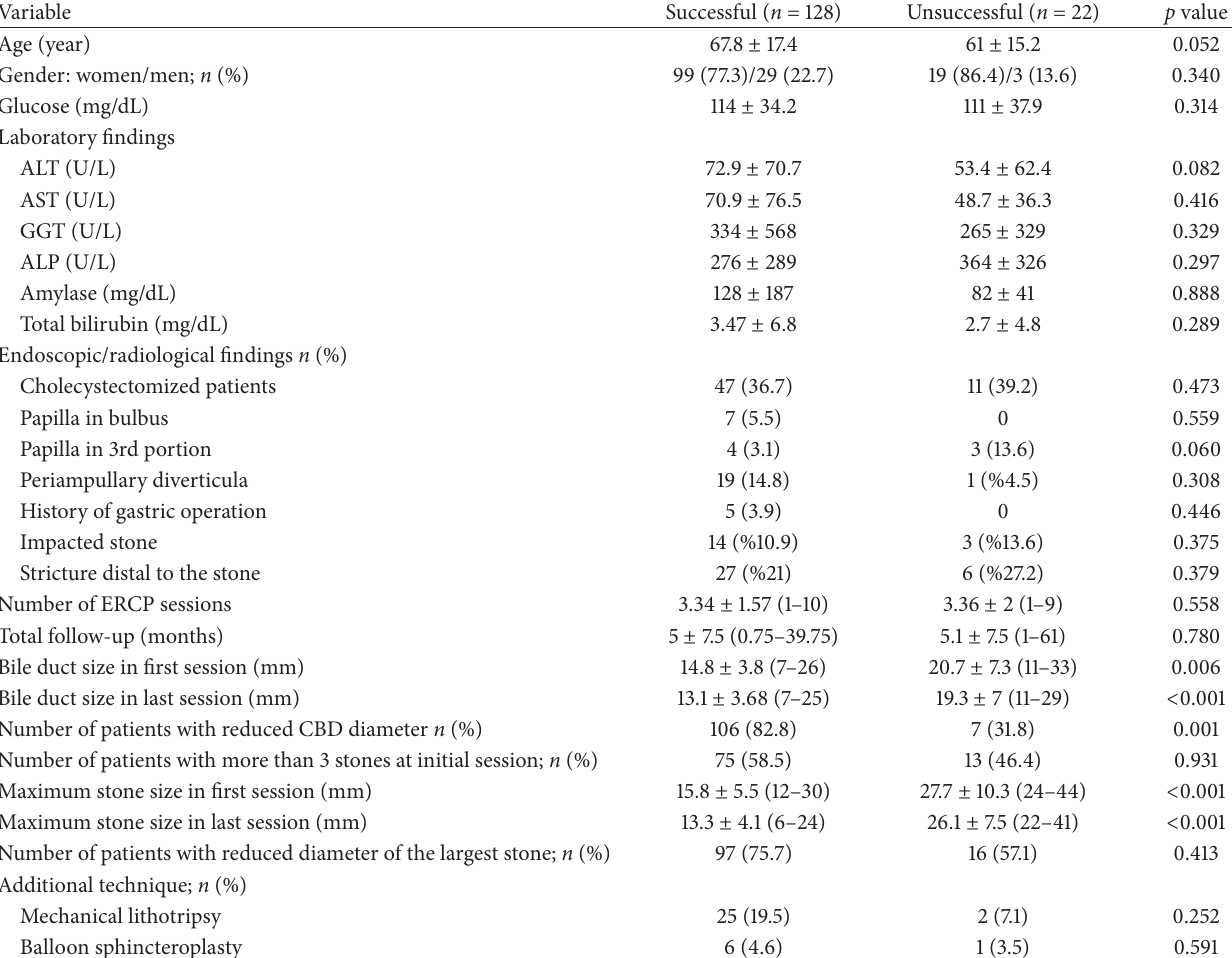
Table 2: Comparison of groups that underwent periodic endobiliary